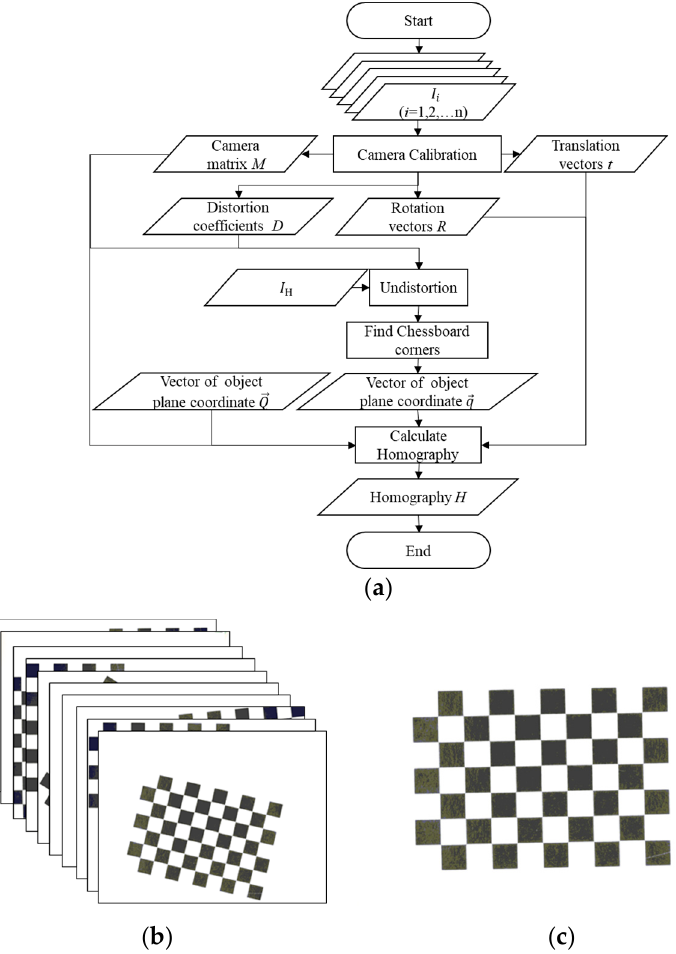
Figure 12. ( a ) Flowchart of pre-processing the dimension measurement; ( b ) images for camera calibration I i ; ( c ) image for calculating homography I H .